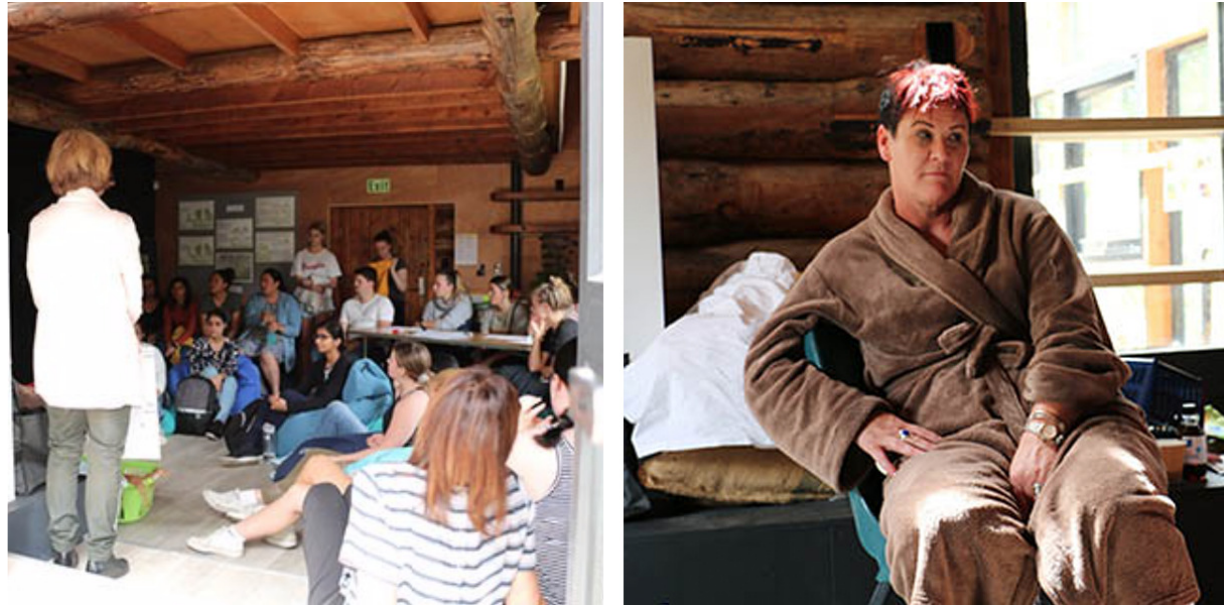
Figure 8. Utilising the LC as a teaching space: A primary health teaching session (left) and improving mental health in action